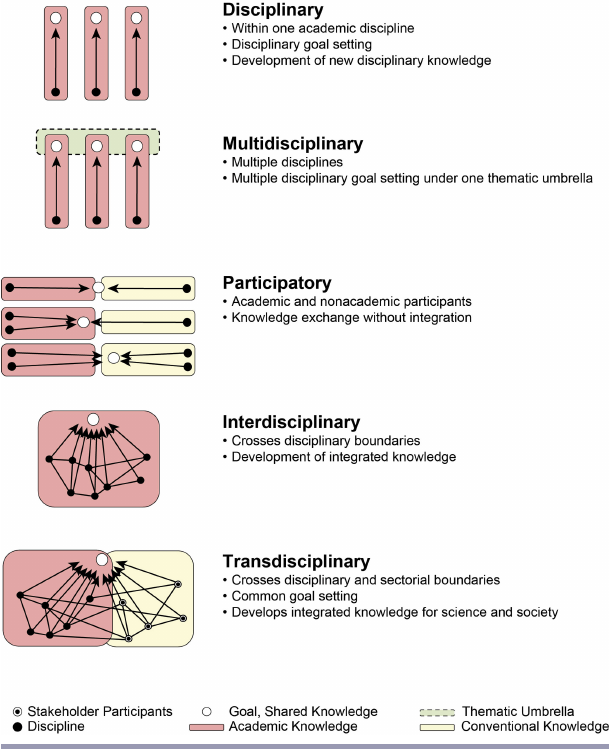
Fig. 1 . Graphical representation of the concepts of disciplinary, multidisciplinary, participatory, interdisciplinary, and transdisciplinary research. Redrawn from Tress et al.